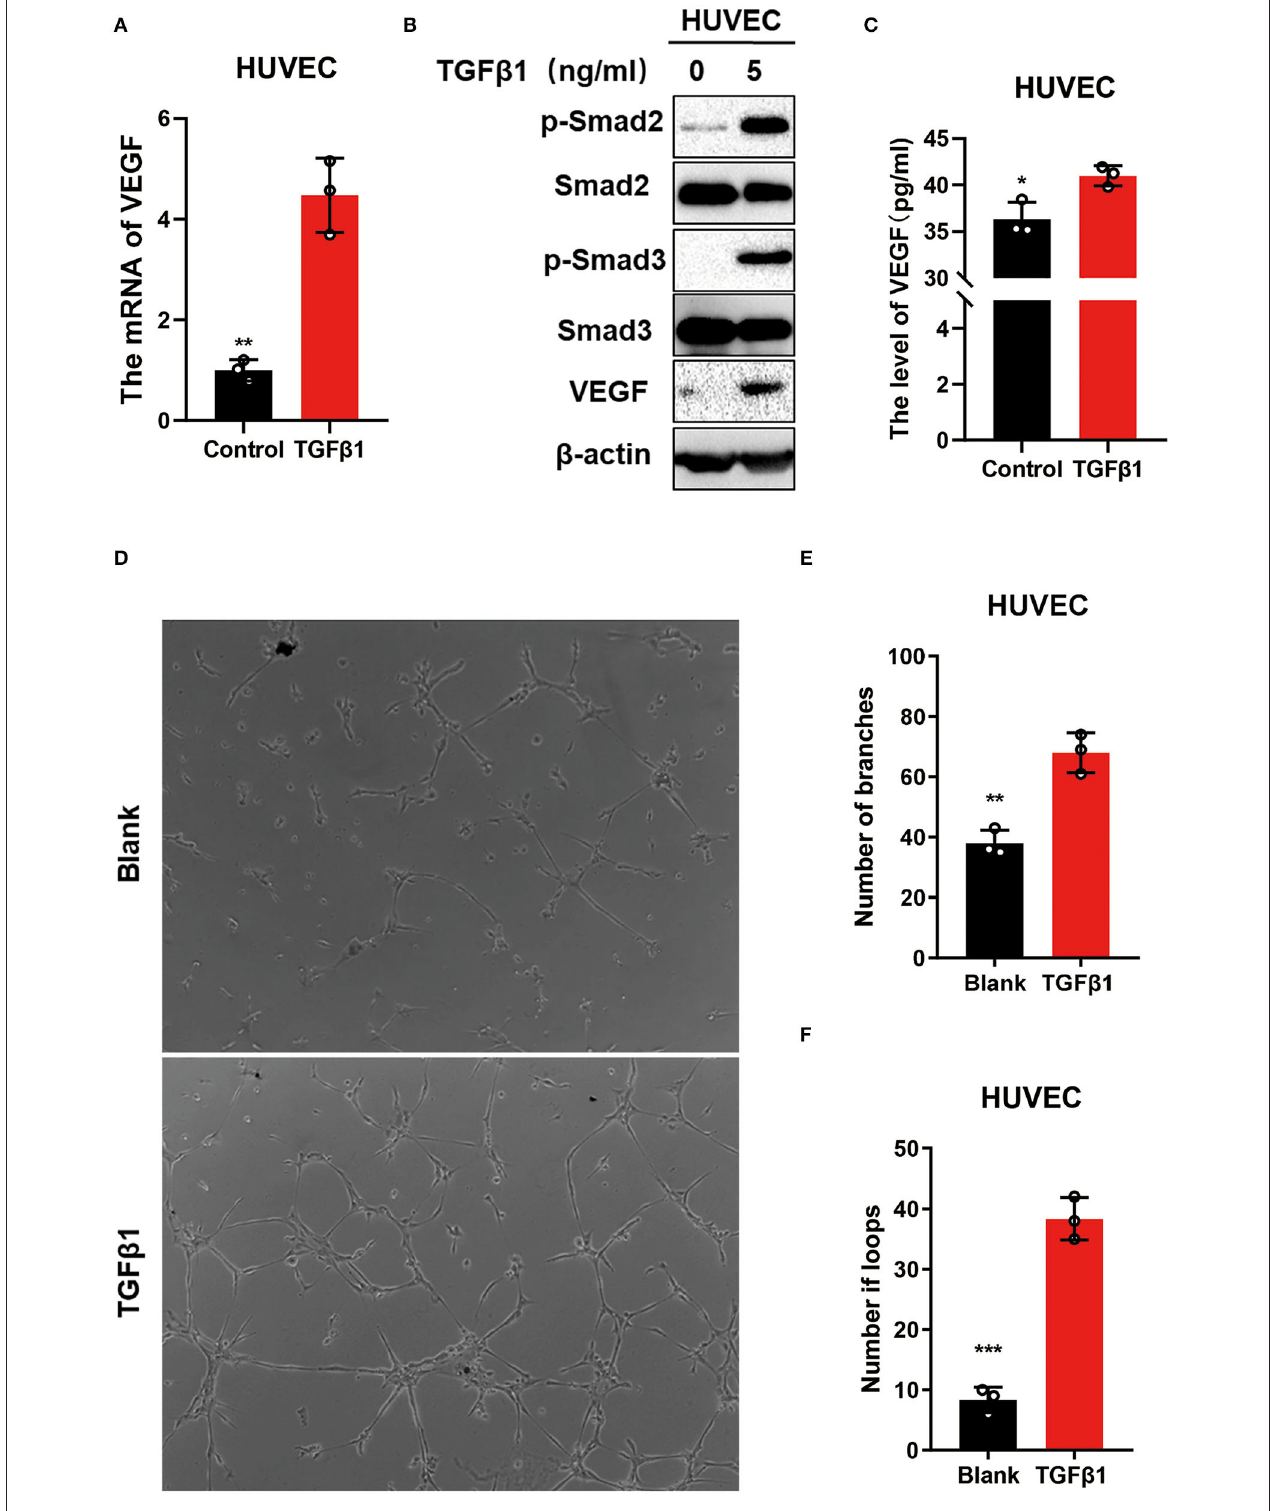
FIGURE 5 | TGF β 1 upregulated VEGF to promote angiogenesis via activating the TGF β signaling pathway in vitro . (A) The mRNA levels of VEGF in HUVECs after stimulating with TGF β 1(5ng/ml) for 24h. (B) Western blot was used to detect the molecular of TGF β pathway. (C) ELISA was performed to identify the level of VEGF in medium after the HUVECs were stimulated with TGF β 1(5ng/ml). (D–F) The tube formation assay was conducted to access the ability of angiogenic in which the HUVECs cultured with the medium from the HUVECs treated with TGF- β 1. * p < 0.05, ** p < 0.01, *** p < 0.001.